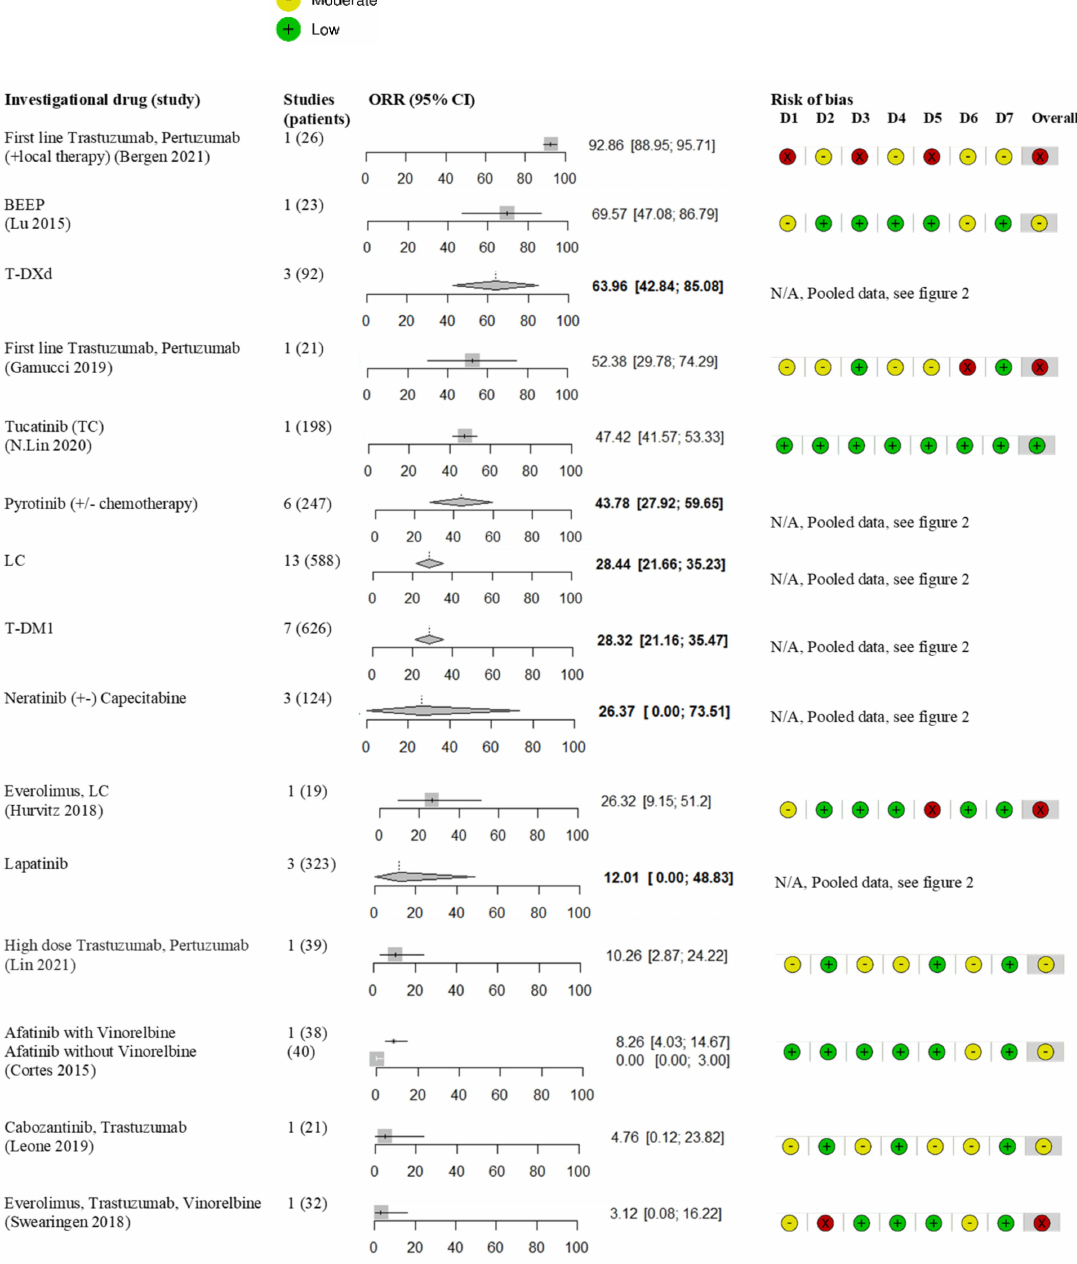
Figure 3. ORR for all drug (combinations). Overview of single studies, pooled meta-analysis and quality assessment of risk of